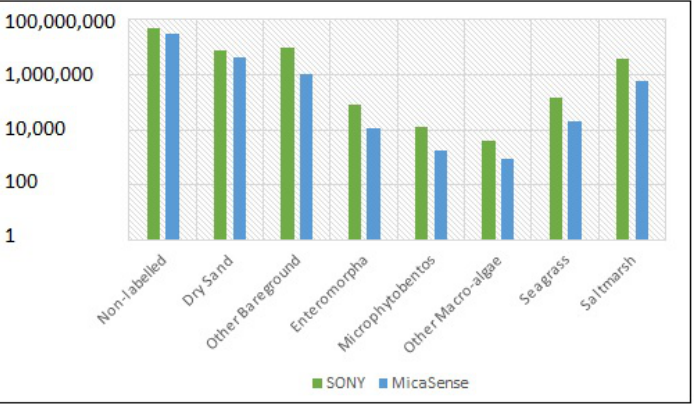
Figure 5. Distribution of labelled pixels for each class and non-labelled